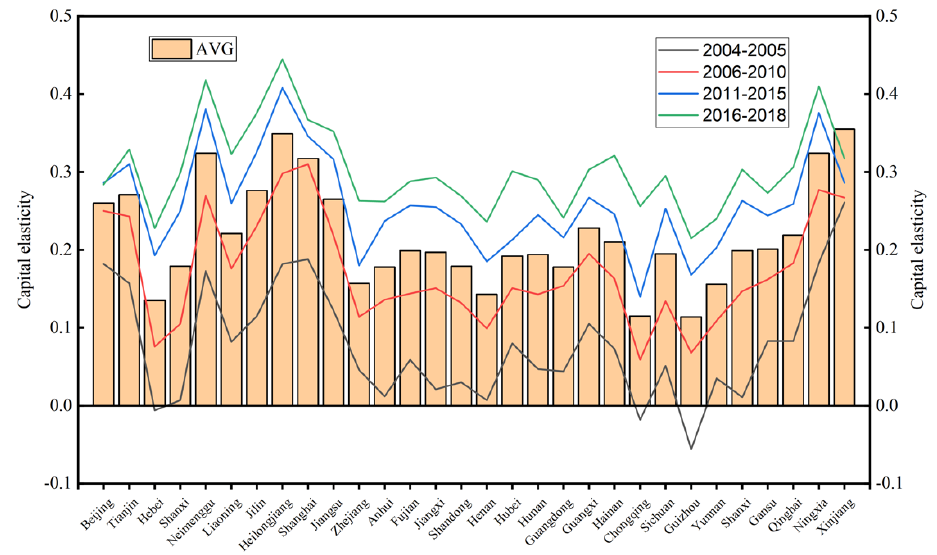
Figure 5. The output elasticity of capital and average level in four different periods.